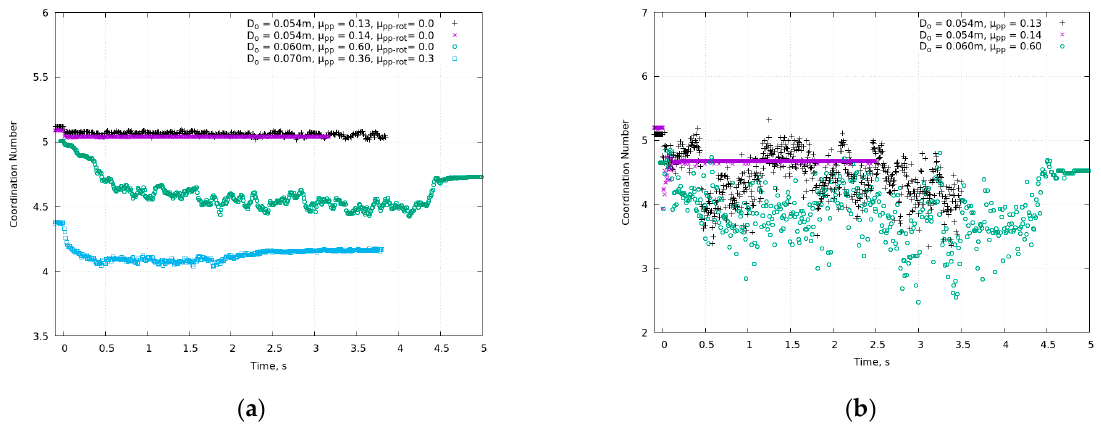
Figure 6. Evolutions of the average coordination number with time at the end of detention (negative times) and after opening the orifice for various values of D 0 , µ pp , and µ rp , for the whole bin ( a ) and in the proximity of the outlet (cylinder 0.11 m high, 0.1 m radius) ( b ).